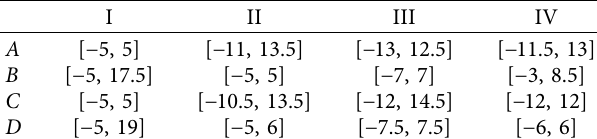
Table 17: Subtract [ − 3.5, 8.5] from uncovered intervals.